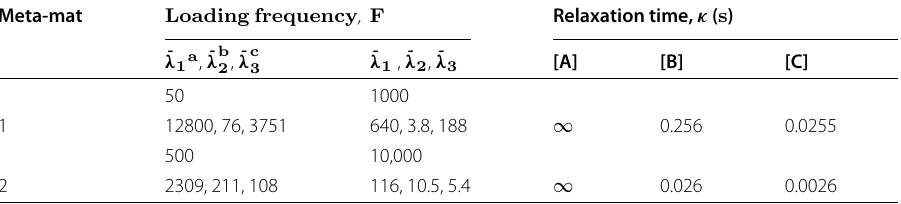
Table 3 Loading frequency F , wavelength ratios ( ¯ λ 1 , ¯ λ 2 , ¯ λ 3 ) and relaxation time κ ( [ A ] , [ B ]